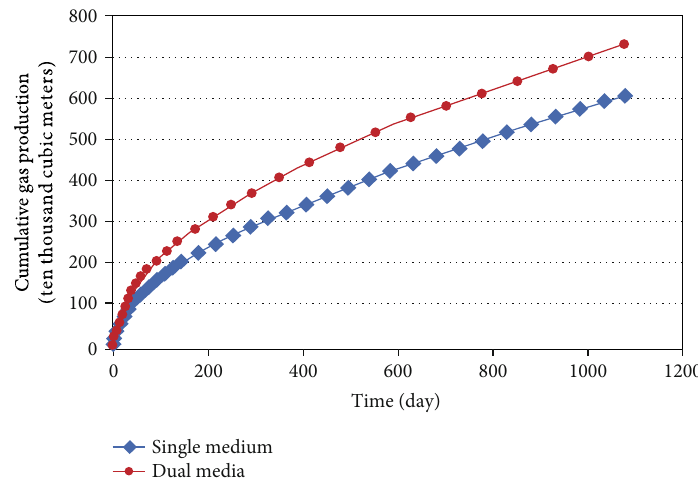
Figure 15: Comparison of cumulative gas production for a single medium and dual